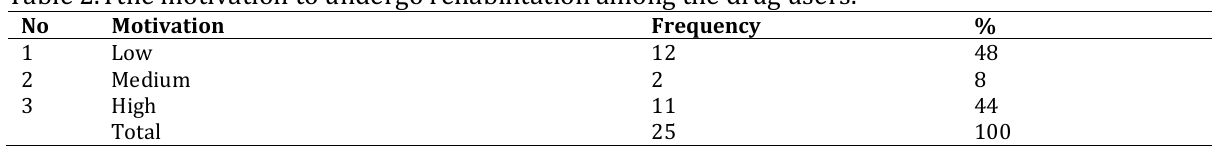
Table 2.Tthe motivation to undergo rehabilitation among the drug users.